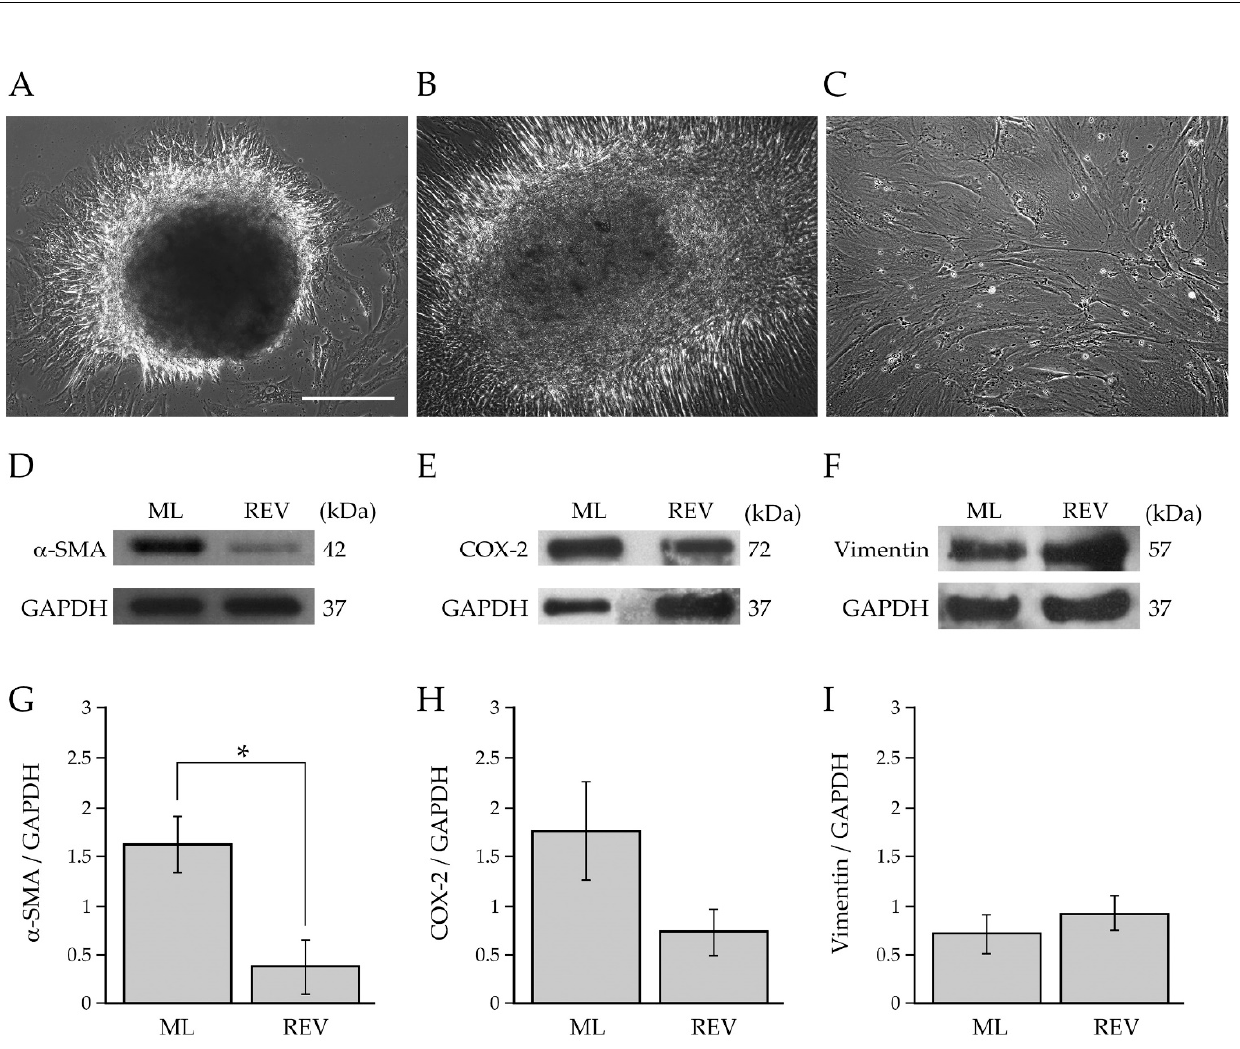
Figure 6. Characterization of reverted BCAFs. ( A , B ) Representative images of the outgrowth and spreading of reverted BCAFs from BCAF spheroids transferred on a conventional 2D cell culture dish to allow 2D cell growth and proliferation after 216 h of 3D cell culture on agar. Reverted BCAFs outgrowing from spheroid after ( A ) 1 day and ( B ) 1 week of 2D cell growth. ( C ) Representative cell morphology of reverted BCAFs by phase-contrast microscopy. Scale bar 200 µm. Magnification ×10. ( D – I ) Western blotting analysis of α -SMA, COX-2 and vimentin in protein extracts of BCAF monolayers (ML) and reverted BCAFs (REV). GAPDH was used as loading control. Representative images of at least three independent experiments are shown. ( G – I ) Densitometric analyses of α -SMA, COX-2 and vimentin protein levels. Data are reported as means of at least three independent experiments ± S.E. * p < 0.05.